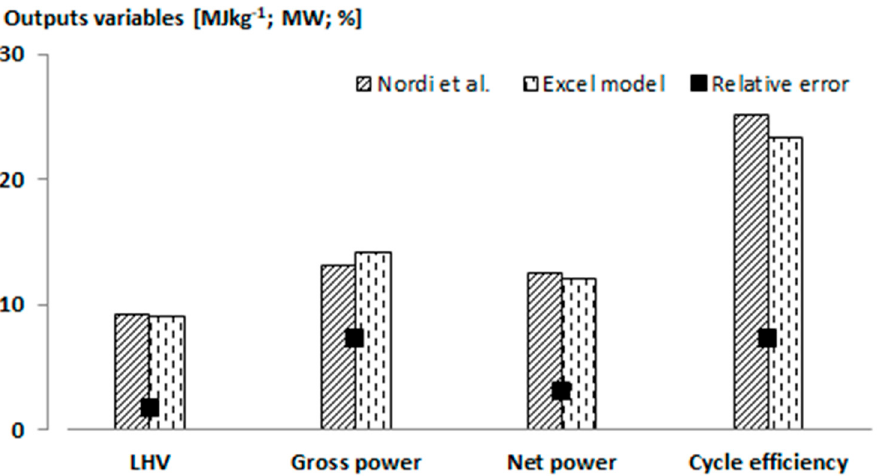
Figure 3. Outputs comparison between the Excel model and the model applied by Nordi et al. (2017).